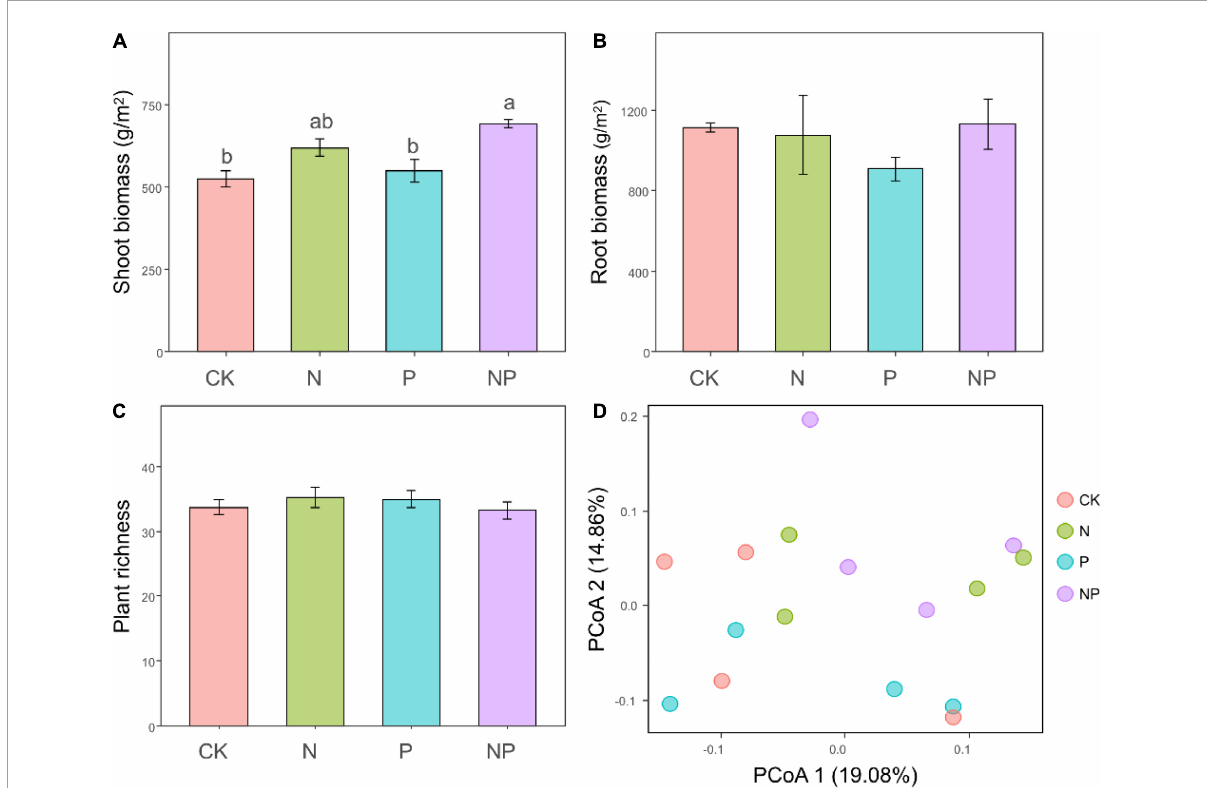
FIGURE1 Shoot (A) , root (B) biomass and plant richness (C) under different treatments. Bars represent means ± SEs. Significant differences of each variable among treatments are indicated by dissimilar letters above boxes ( post hoc Tukey’s test). Principal coordinate analysis ordination (PCoA) plot based on a Bray–Curtis dissimilarity matrix of plant communities under different treatments (D)